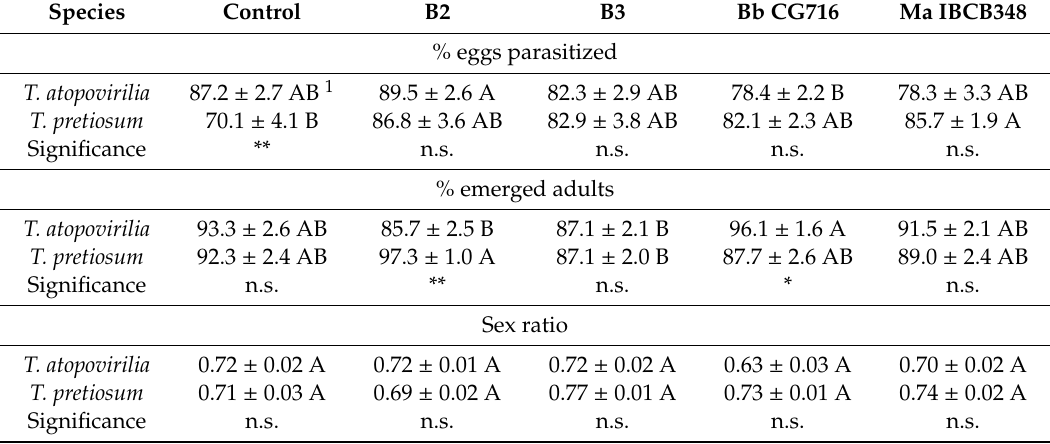
Table 1. Biological parameters (% eggs parasitized, % emerged adults, and o ff spring sex ratio) of Trichogramma atopovirilia and Trichogramma pretiosum individuals emerged from Duponchelia fovealis